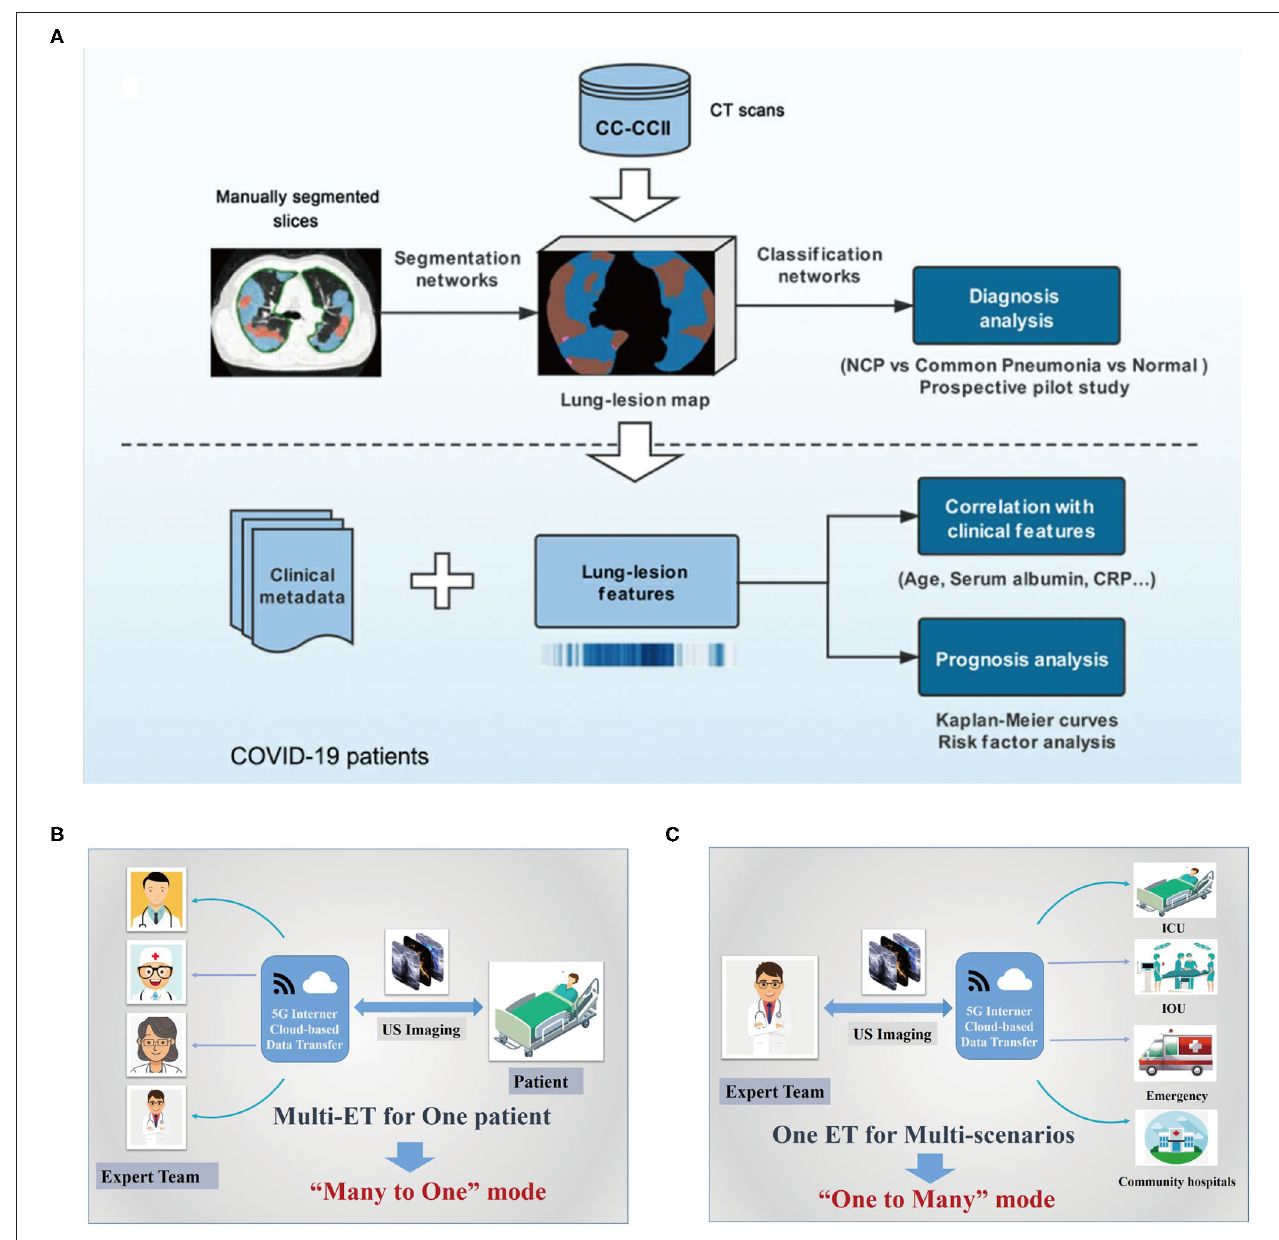
FIGURE 6 | Digital technology-based tele-radiology system used during this COVID-19 outbreak. (A) The artificial intelligence (AI) framework for COVID-19 diagnosis and prognosis prediction based on CT imaging (58). (B,C) Schematic diagram of the basic structure of tele-ultrasound system based on 5G internet cloud-based data transfer, the “many to one” mode (A) and “one to many” mode (59, 60). COVID-19, coronavirus disease 2019; NCP, novel coronavirus pneumonia; CRP, C-reactive protein; CT, computed tomography; 5G, fifth generation; PC, picture archiving and communication system; IOU, intraoperative ultrasound; ICU, intensive care